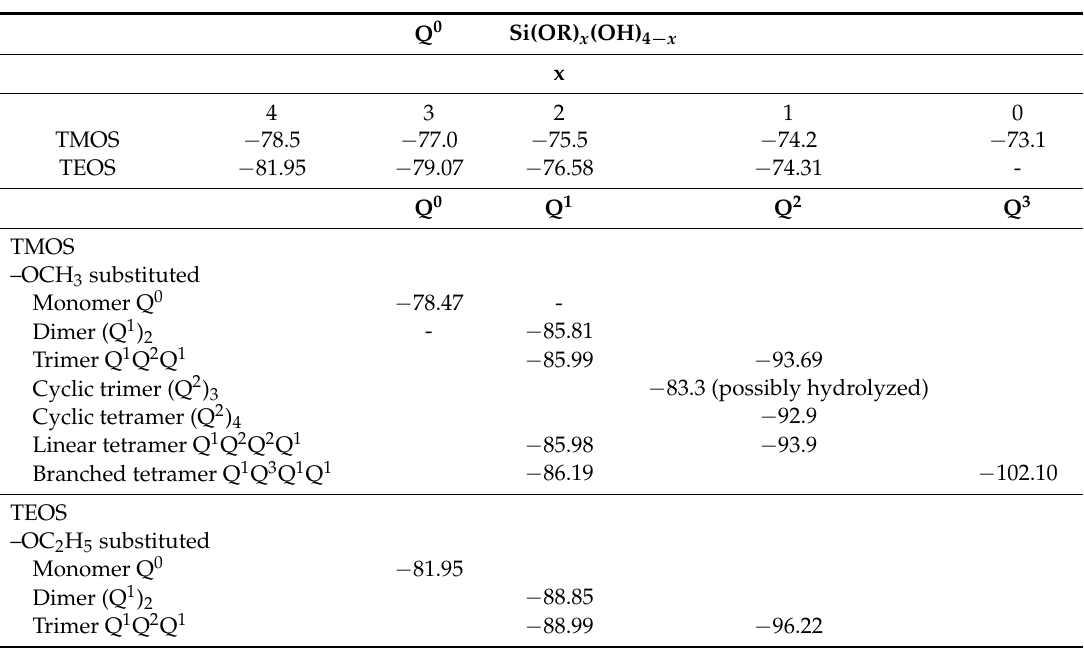
Table 5. The chemical shifts from the Q-species (hydrolyzed monomers and oligomers) of TEOS and TMOS. Here, the Q represents the quaternary functional silanes. Reprinted with permission from [4]. Copyright Elsevier,